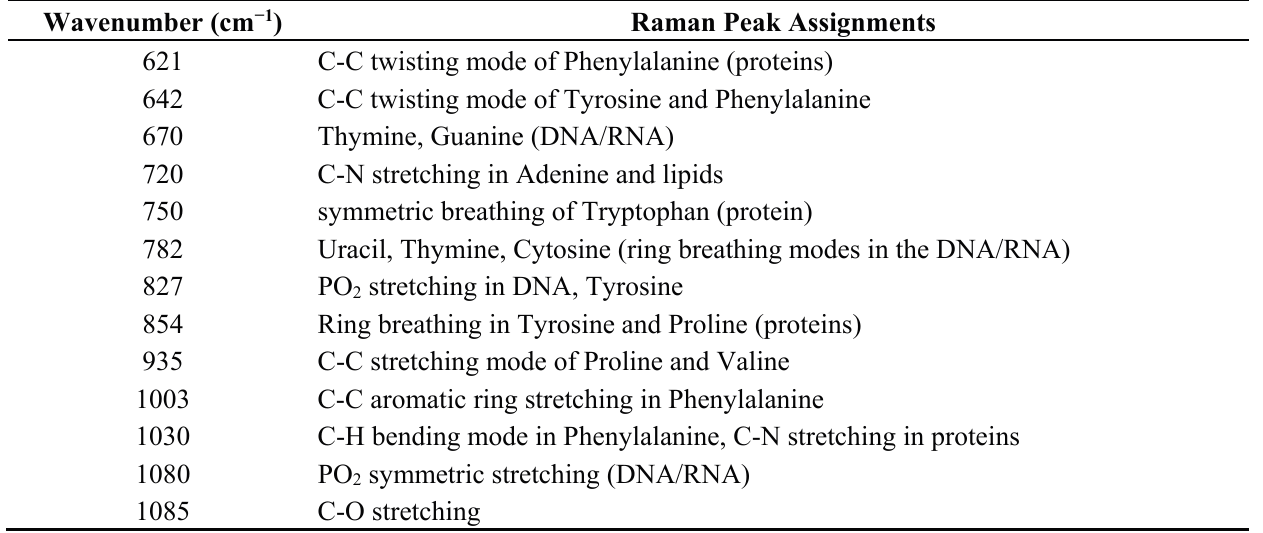
Figure 3. Typical cellular Raman spectrum. Table 2. Tentative peak assignments [4] for typical Raman cellular spectrum shown in Figure